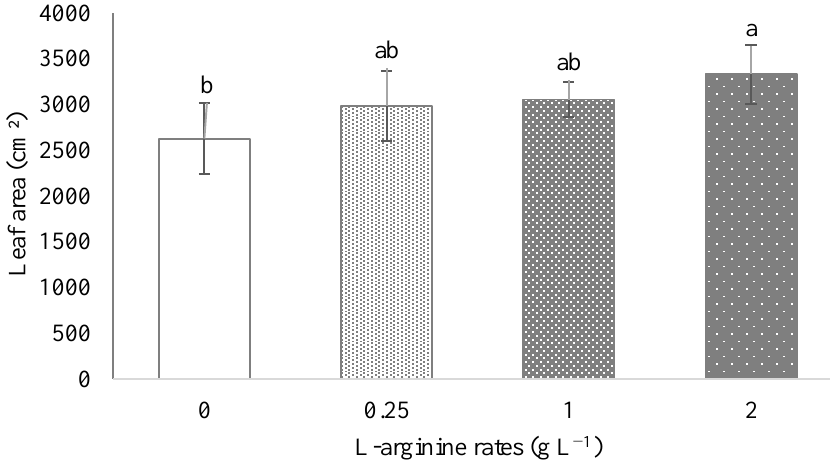
Figure 3. Leaf area of ora-pro-nobis plants treated with different L-arginine rates applied by drenching. Data followed by the same letter did not differ from each other by Tukey range test at p ≤ 0.05. Table 3. Fresh mass (g), dry mass (g) and water content (%) of ora-pro-nobis plants treated with different L-arginine rates applied by drenching.